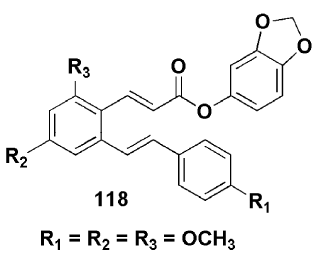
Figure 31. Chemical structure of compound 118 [83].